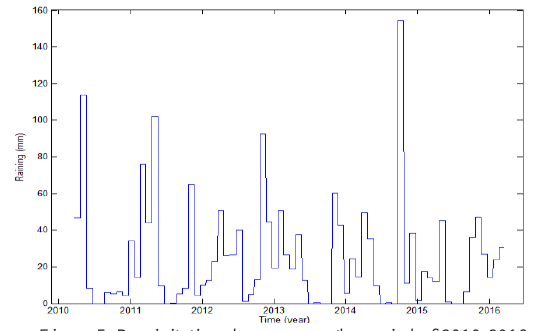
Figure 5: Precipitation changes over the period of